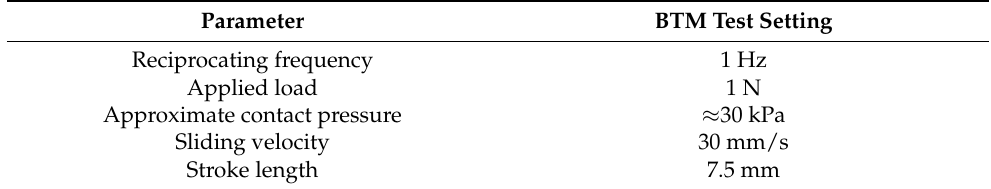
Table 2. Test parameters used for the BTM to mimic physiological oral cavity conditions [29,34].